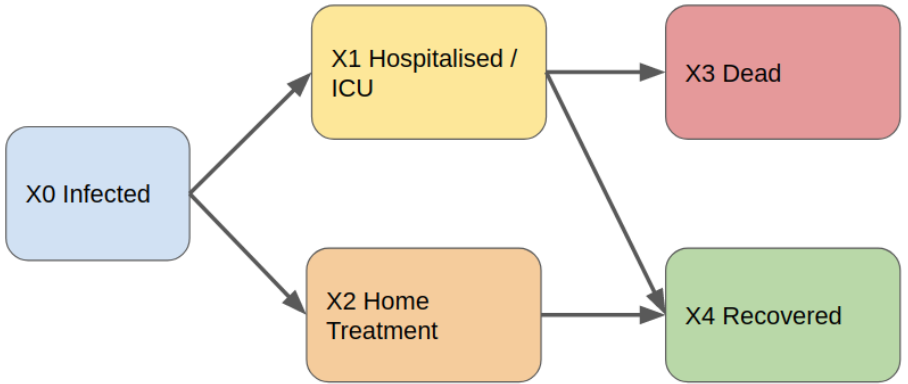
Figure 1. The Compartmental Model. Our model start by considering infected people ( X 0). A fraction of infected people presents severe symptoms and they need to be hospitalised and treated in ICUs ( X 1). Diversely, some people may be treated at home ( X 2) since they do not have severe complications. Treated people has a lethal outcome ( X 3) while a hopefully large fraction of people is recovered from